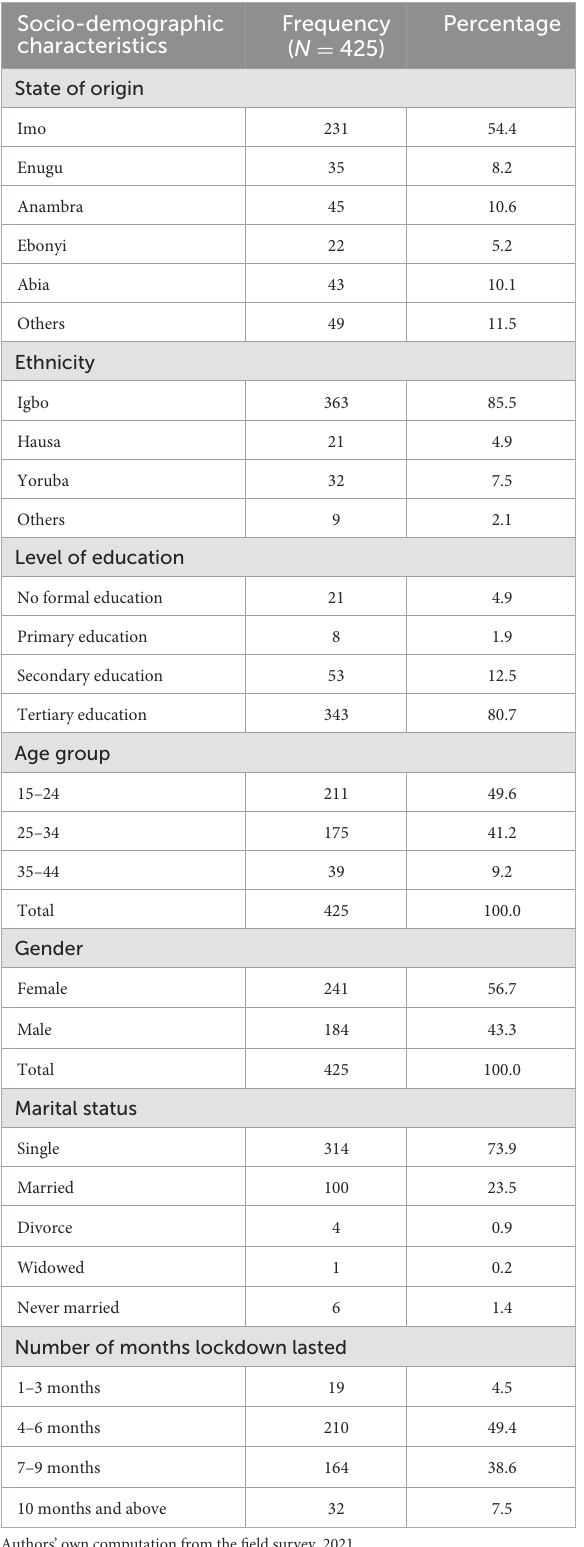
TABLE 2 Distribution of respondents by socio-demographic characteristics. Socio-demographic